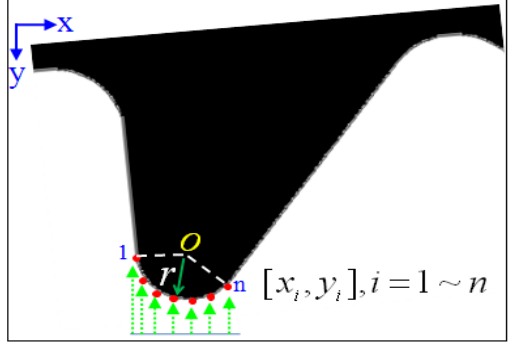
Figure 7. “Radius of tooth top r”.